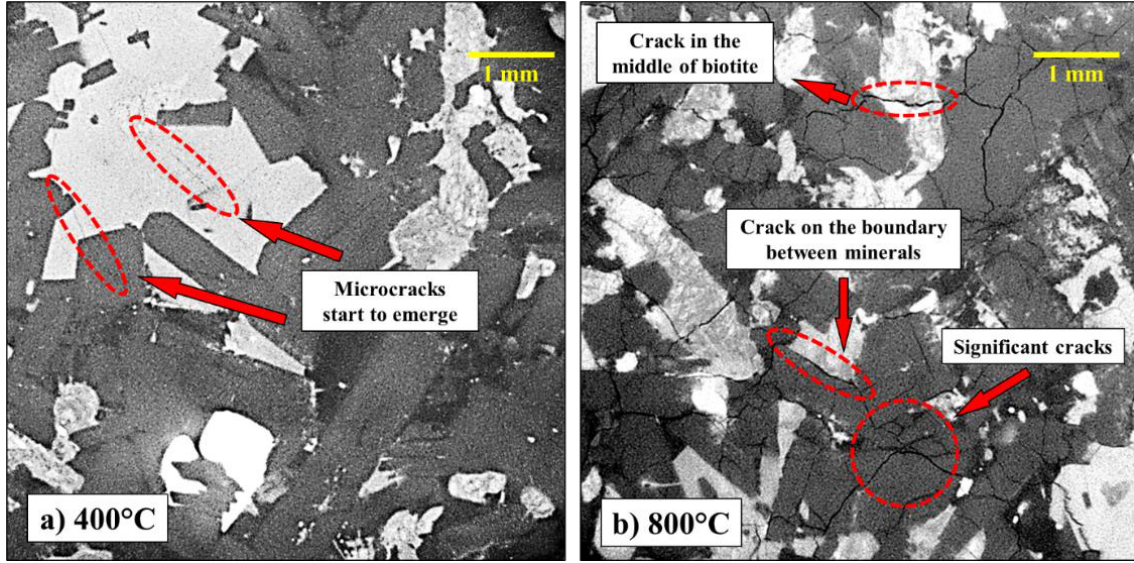
Figure 9. Details of thermal cracks on norite after ( a ) 400 °C and ( b ) 800° C treatment.